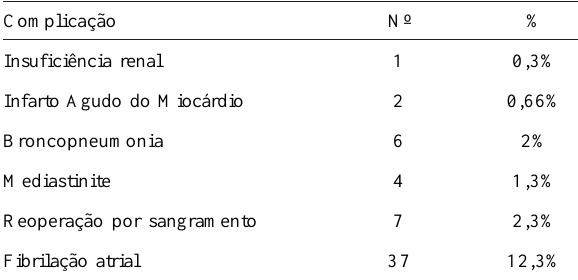
Tabela 1. Complicações